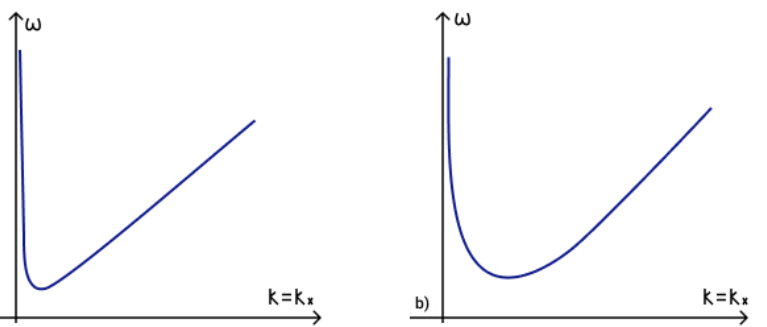
Figure 2. Dispersion curves of ( a ) magneto-Rossby wave in an external vertical magnetic field ω MR and ( b ) magneto-Rossby wave in an external vertical magnetic field with correction due to 1 + δ stratification ω MR 1 . 1